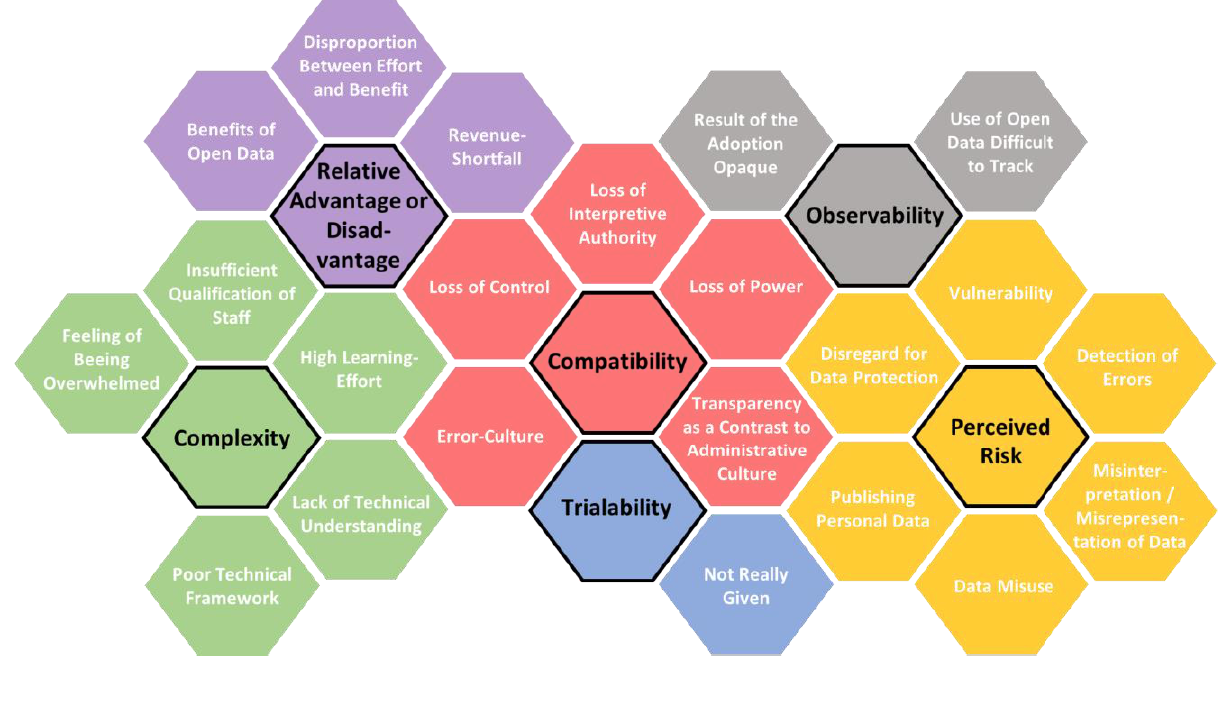
Figure 2: Aspects of negative attitudes towards Open